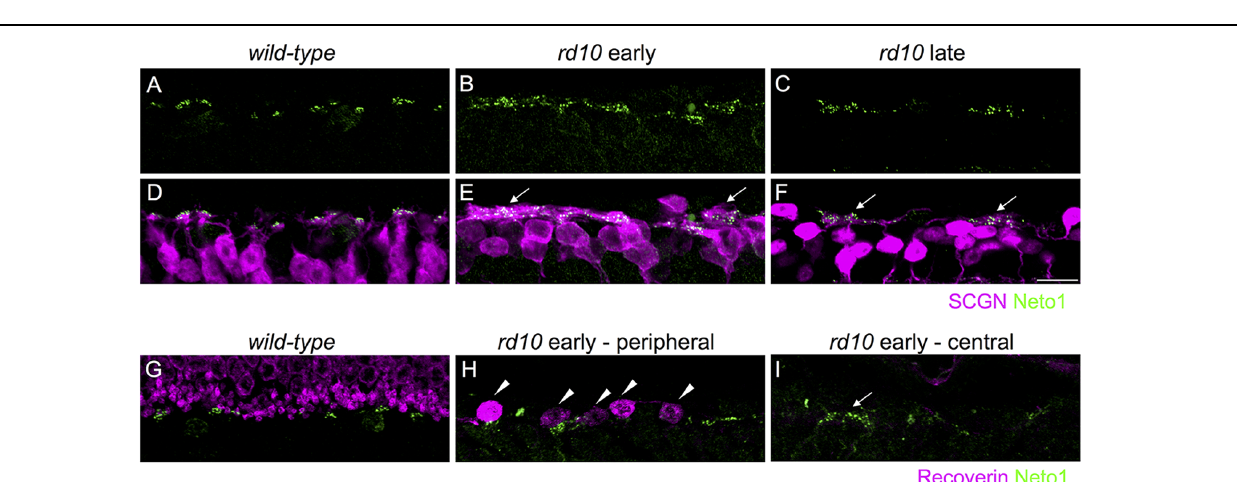
Next, we assessed the localization of TRPM1, the non-selective cation channel coupled to mGluR6 in On bipolar cells (Morgans et al., 2009; Shen et al., 2009; Koike et al., 2010). In wild-type retina, TRPM1 was localized to puncta in the outer plexiform layer as well as in the somata of On bipolar cells, consistent with previous reports ( Figure 4A ) (Morgans et al., 2009; Koike et al., 2010). In the rd10 retina, punctate TRPM1 staining was absent,